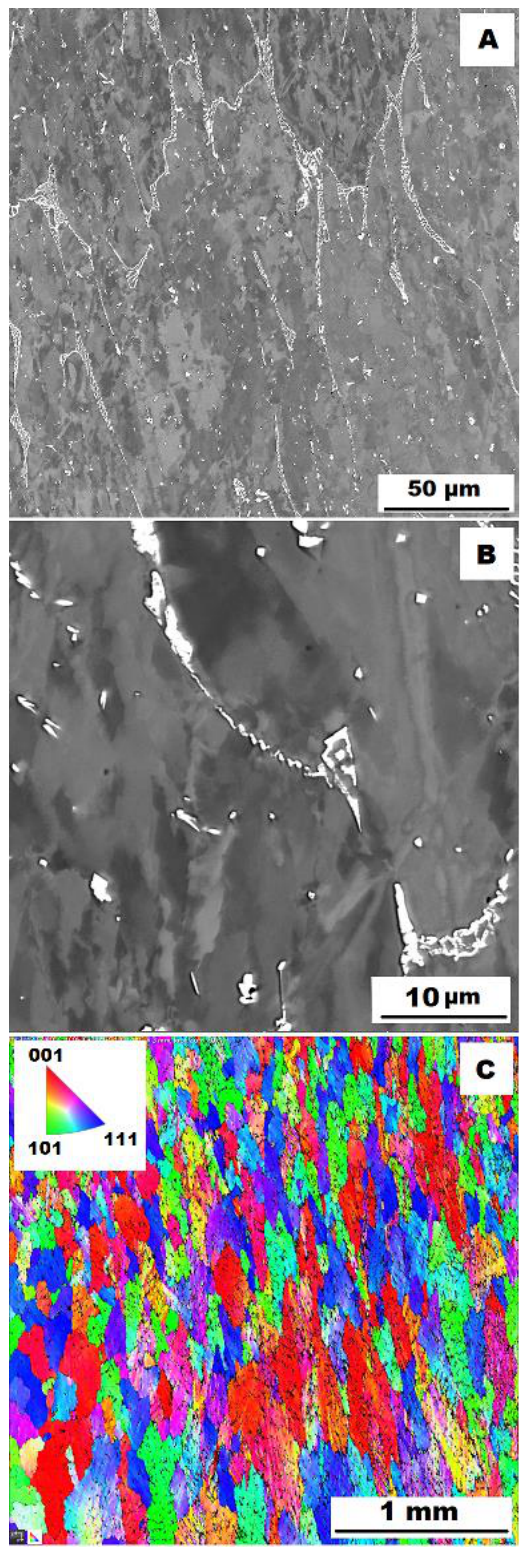
Figure 15. The structure of Fe – 28Al – 5Si – 2Mo – 1B HT 800/100 alloy after compression test at 600 °C. ( A ) Overview of the structure-10 kV, BSE. ( B ) Detail of the structure-10 kV, BSE. ( C ) EBSD map of grains-area 3 × 3 mm, step size 2 µm, 20 kV.